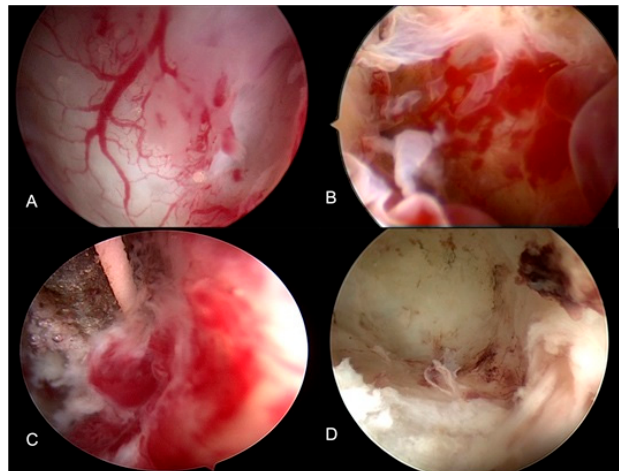
Figure 7. Transvaginal hydro laparoscopy images of an endometrioma before ( A ) and after ( B ) sur- gery of endometriosis. ( A , B ): ovarioscopic view: note neoangiogenesis and endometrium-like tissue. ( B ) surgery of endometriosis. ( A , B ) ovarioscopic view: note neoangiogenesis and endometrium-like ( C ): superficial coagulation using 5Fr bipolar probe. ( D ): Final result after coagulation: minimal trauma, no carbonization.(67) tissue. ( C ) superficial coagulation using 5Fr bipolar probe. ( D ) Final result after coagulation: minimal trauma, no carbonization